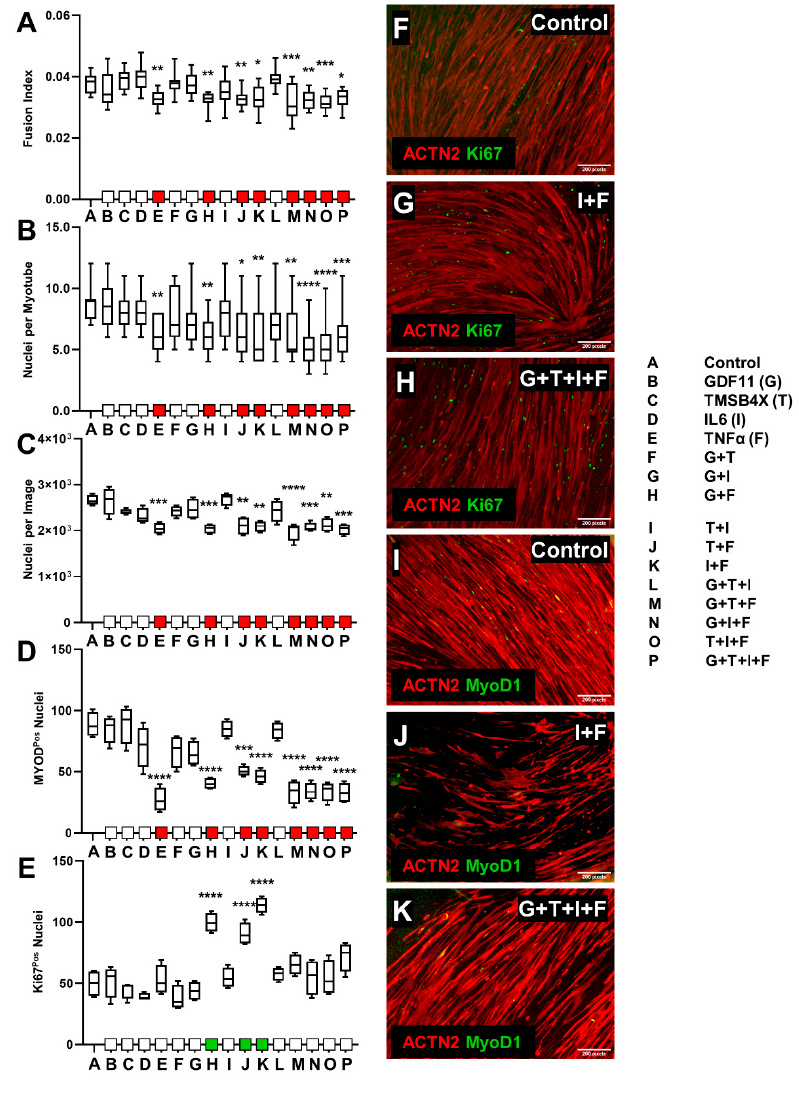
Figure 5. Effect of ligand combination exposure on differentiation of skeletal muscle cells derived from tHFs. Cells were transduced with MYOD1 fragments and induced to express the skeletal muscle phenotype via the induction of doxycycline and SB431542 over a 7-day period. Ligand combinations of GDF11 (G), TMSB4X (T), IL6 (I), and TNF- α (F) at 10 ng/mL were introduced for an additional week, and SB and Dox administration was discontinued. Skeletal muscle cells were fixed and stained on day 14 and characterized by various differentiation and proliferation parameters from 5 × microscopy. ( A ) Fusion index of tHFs was evaluated by determining the ratio of myotube nuclei vs total nuclear count ( n = 16, mean + SD). ( B ) Cellular multinucleation was quantified to assess tHF development of differentiation ( n = 22, mean + SD). ( C ) Nuclear density was similarly assessed by quantifying nuclear count per field ( n = 4, mean + SD). ( D ) Nuclear MYOD1 was quantified ( n = 6, mean + SD). ( E ) Ki67 nuclei were also assessed with a nuclear count ( n = 6, mean + SD). ( F ) Control tHF myotubes were immunostained with ACTN2 and Ki67. ( G ) IL6 and TNF- α combination demonstrated significant decrease in differentiation parameters fusion index, multinucleation, myotube length, and diameter (Supplementary Figure S4C,D), although Ki67+ expression had increased. ( H ) Exposure of tHFs to combined GDF11, TMSB4X, IL6, and TNF- α showed similar results, however nuclear Ki67 expression was unchanged. ( I ) Untreated tHFs with ACTN2 and MYOD1 nuclear stains. ( J ) Cells treated with IF showed a decrease in MYOD1 nuclear expression. ( K ) Additionally, GDF11, TMSB4X, and IL6 exposure yielded similar results with respect to MYOD1+. * p < 0.05, ** p < 0.01, *** p < 0.001, **** p <